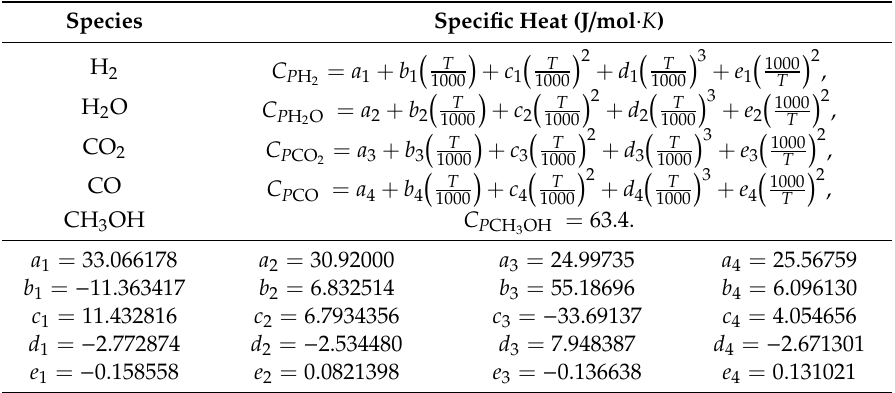
Table 2. Specific heat of gases.